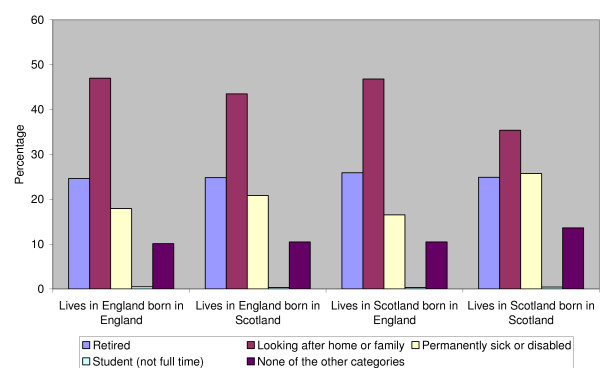
Classification of economically inactive women.